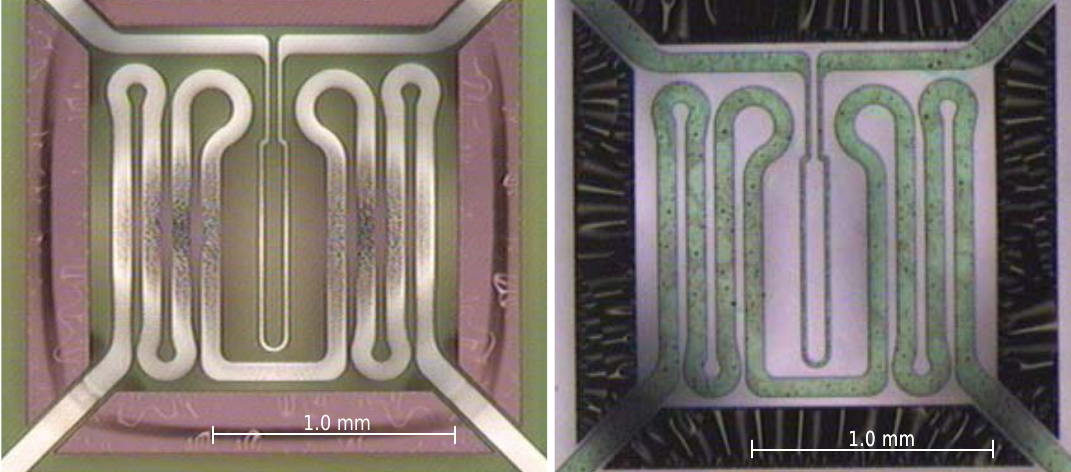
Figure 11. (left) Degradation of a Pt resistor at the two hotpots of an emitter hotplate operating for 31 hours at 1100 K. The metallisation is seen to develop an increasing porosity until resistor failures :Sb based resistor after 18 hours of operation at 1300 K. Here, no significant occur; (right) an SnO 2 degradation can be